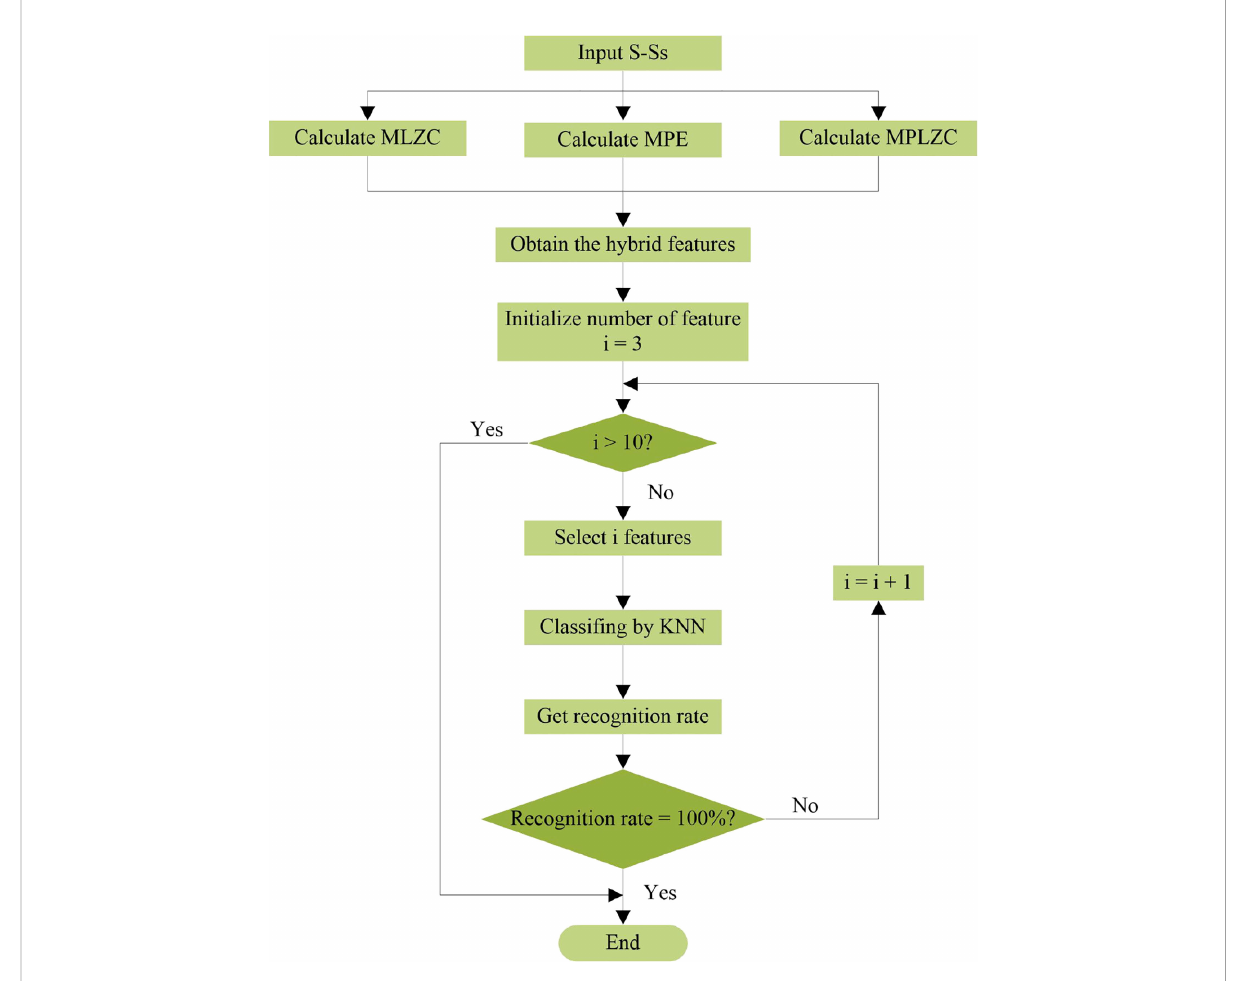
FIGURE 1 Flow chart of the automatic hybrid multi-feature extraction for